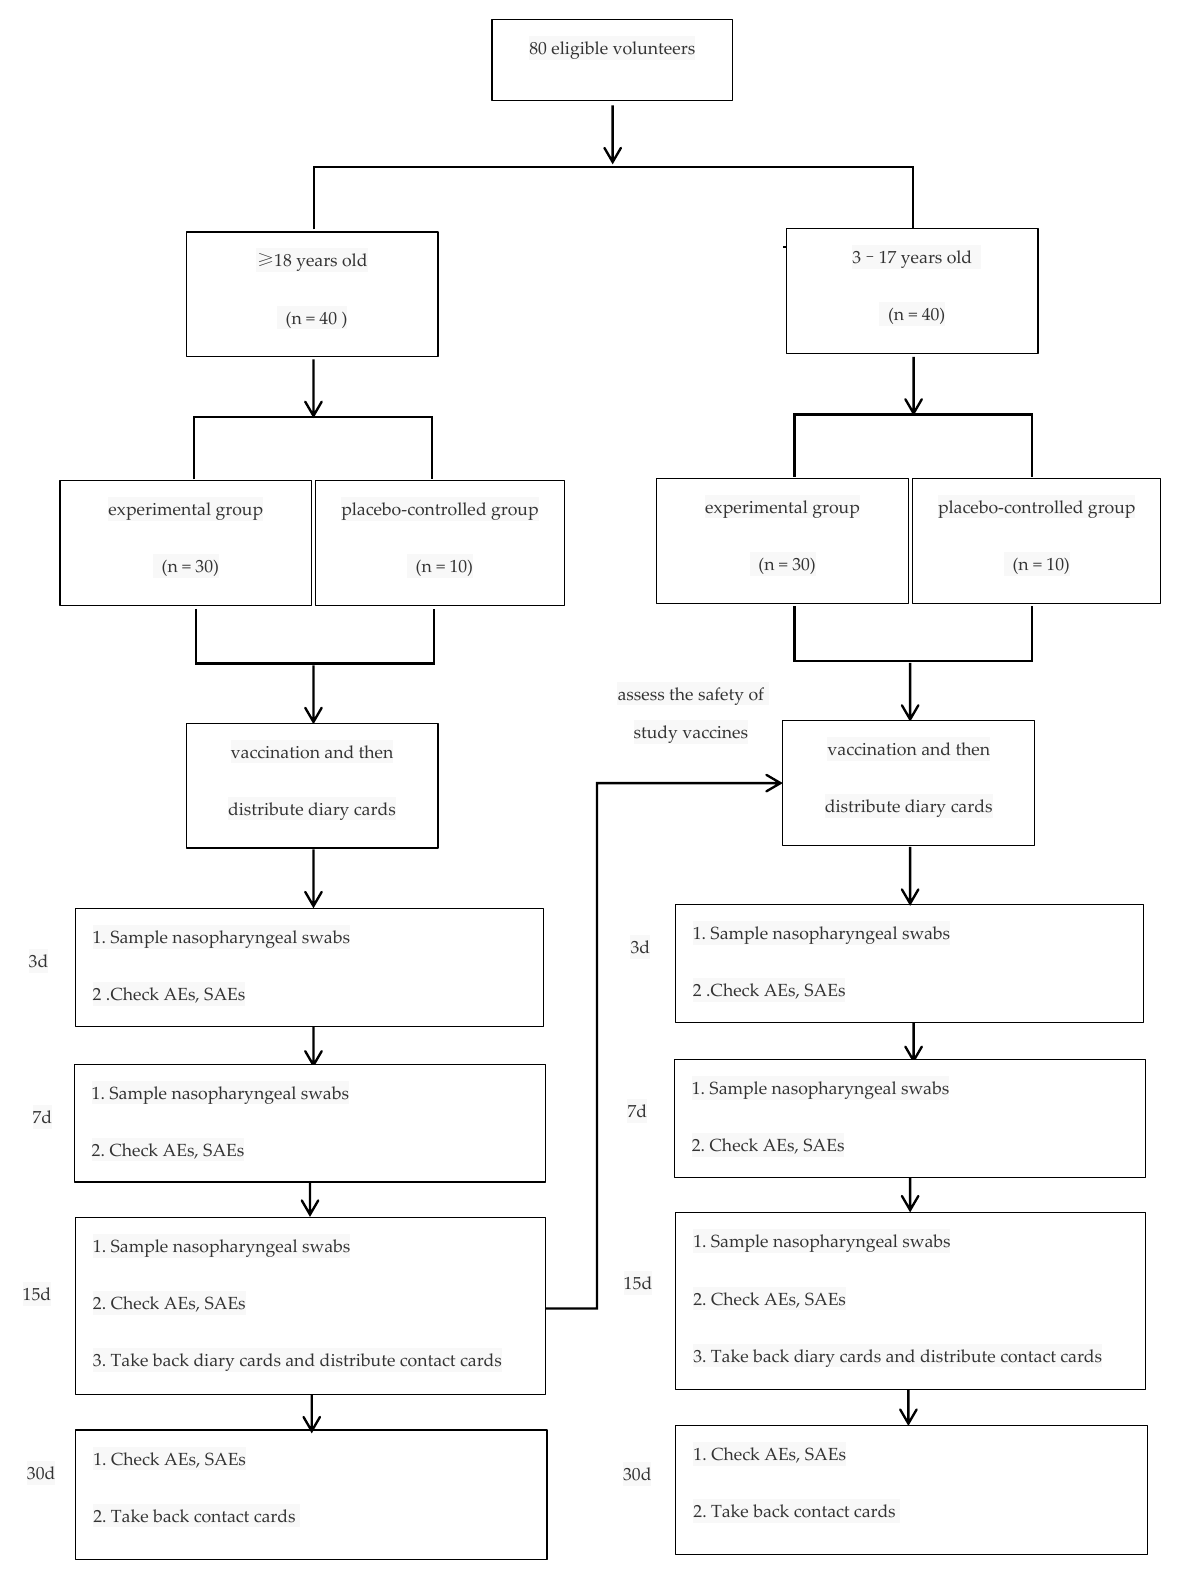
Figure 1. Diagram for study design. (1. Volunteers were randomly assigned to experimental and placebo-controlled groups by a ratio of 3:1; 2. 3 – 17 years old were permitted to be vaccinated only when the incidences of grade 3 and grade 4 adverse events lower than 15% at 14 days after vaccination were